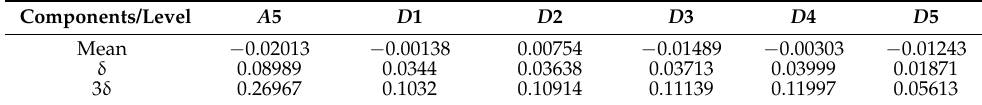
Table 1. Normal distributions for five levels of the RWE prediction errors. Figure 9. Results of the RWE–LSTM model prediction with five levels of the RWE ( left ) and histo- grams of the prediction errors with normal distribution analysis ( right ).